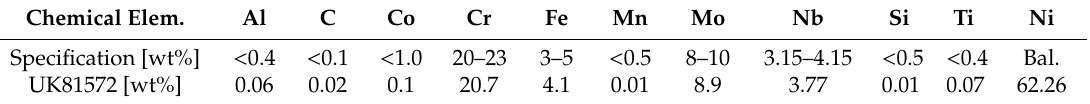
Table 1. Chemical composition of the IN 625 metal powder provided by LPW Technology Ltd. Chemical